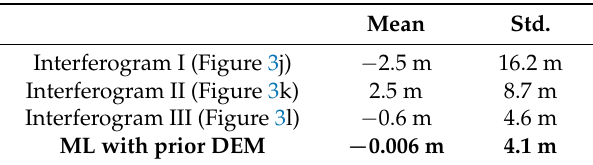
Table 4 . Statistical values of height errors with atmospheric effects. Table 4. Statistical values of height errors with atmospheric